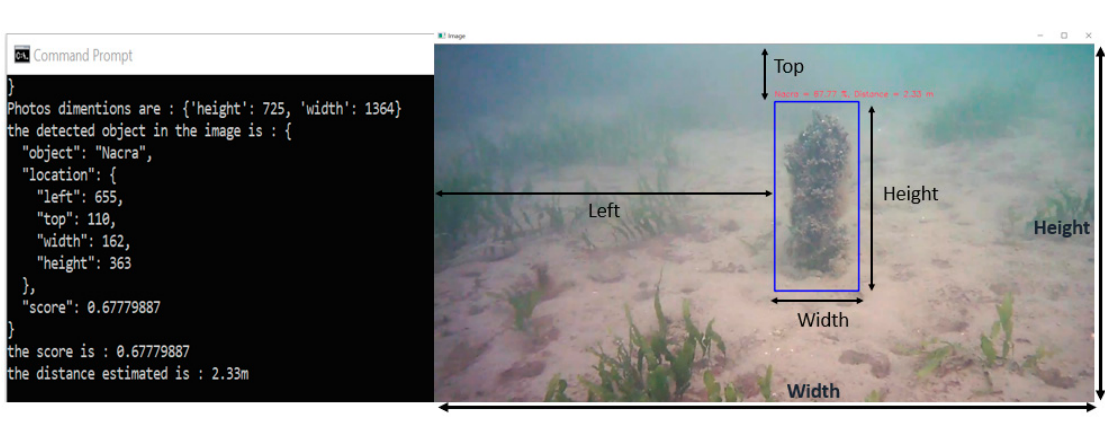
Figure 6. Pictures used for custom CV model training.